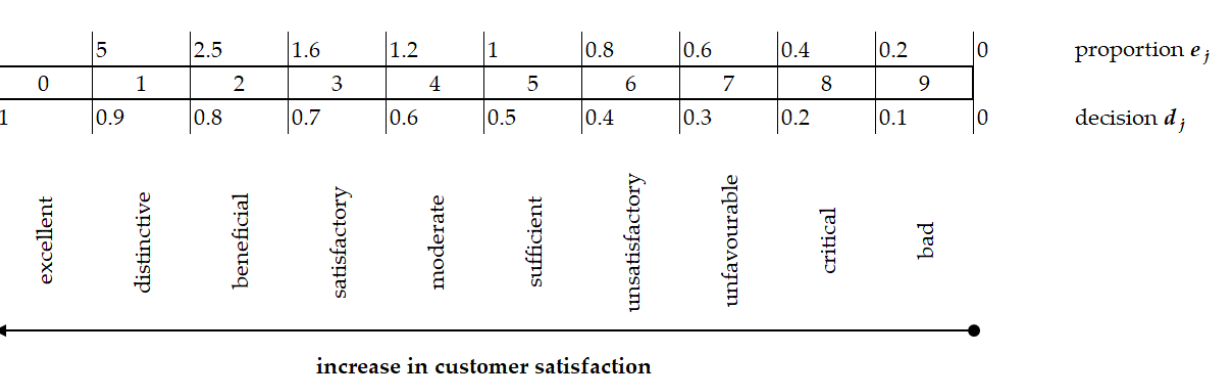
Figure 3. Relative state scale to determine customers’ satisfaction from product quality level. Own study based on [3,4].